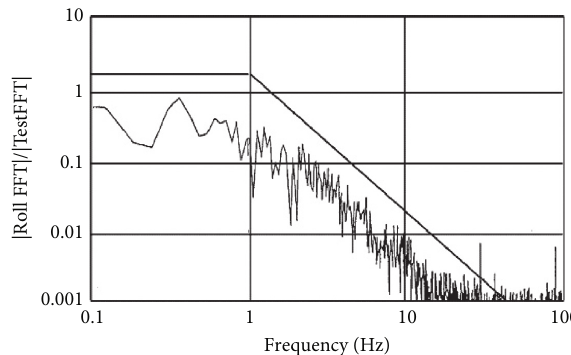
Figure 4: PAV30 rolling dynamic suppression spectrum.